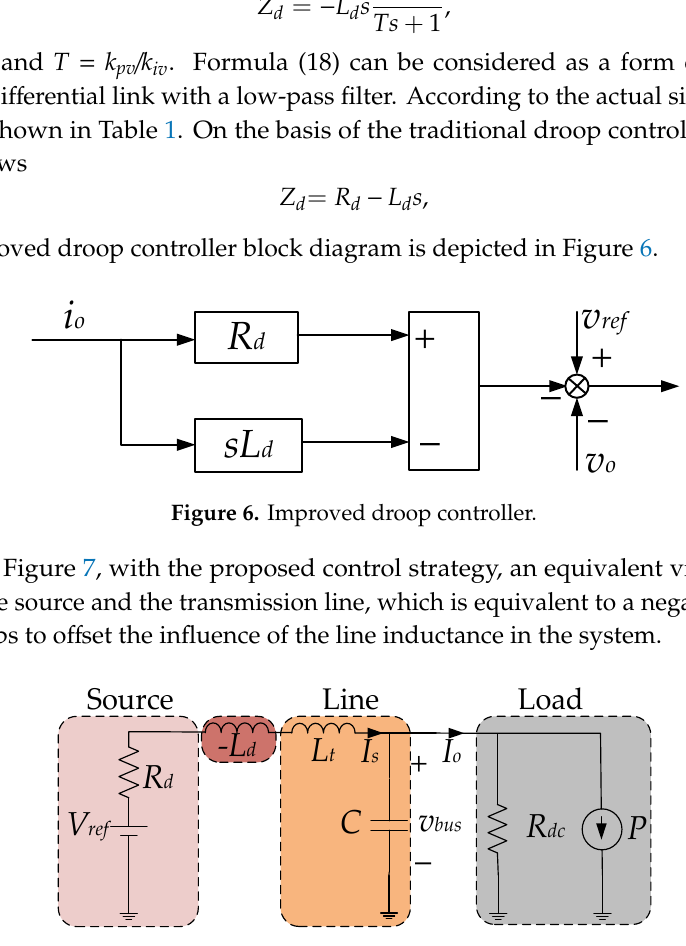
Figure 7. Virtual negative inductive reactance control strategy.